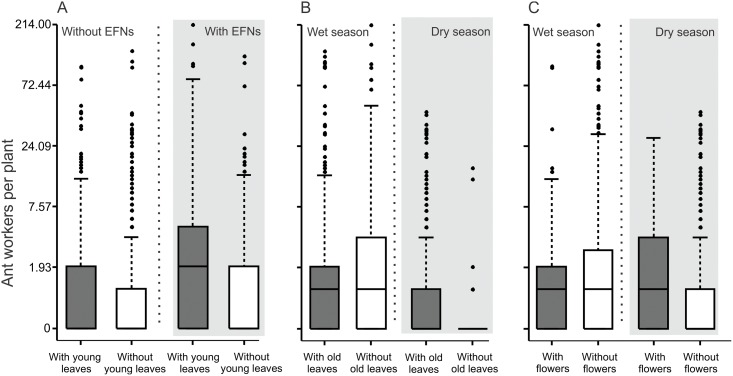
Ant visitation patterns on Cerrado plants according to phenological factors.Plants with and without old leaves according to the seasons (A), plants with and without flowers or floral buds according to the seasons (B). Black horizontal lines represent the median, boxes designate the second and third quartiles, and vertical bars indicate the range of data without outliers. Asterisks indicate significant differences (P < 0.5) between adjacent pairs of categories following contrast procedure.